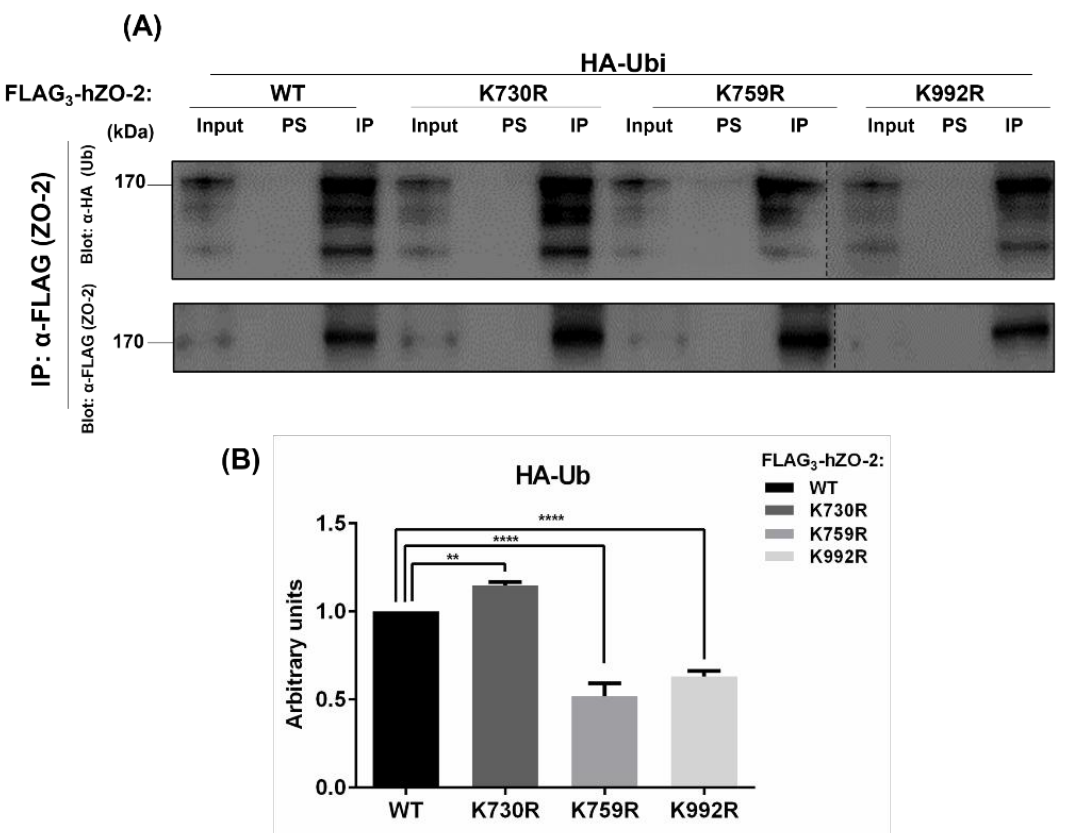
Figure 2. Residues K759 and K992 of hZO-2 are ubiquitination targets. MDCK cells were co-transfected with HA-ubiquitin (HA-Ubi) and Flag 3 -hZO-2-WT or the mutants FLAG 3 -hZO-2-K759R, -K992R, or -K730R. Cell lysates were immunoprecipitated (IP) with anti-FLAG antibody or pre-immune serum (PS), and the precipitates were analyzed by Western blotting with anti-HA (Ubi) and anti-Flag (ZO-2) antibodies. Upper panel ( A ), representative Western blot; lower panel ( B ), quanti- tative analysis of three independent experiments. Statistical analysis was done with One-way ANOVA followed by Bonferroni’s multiple comparison test; ** p < 0.01, **** p < 0.0001.